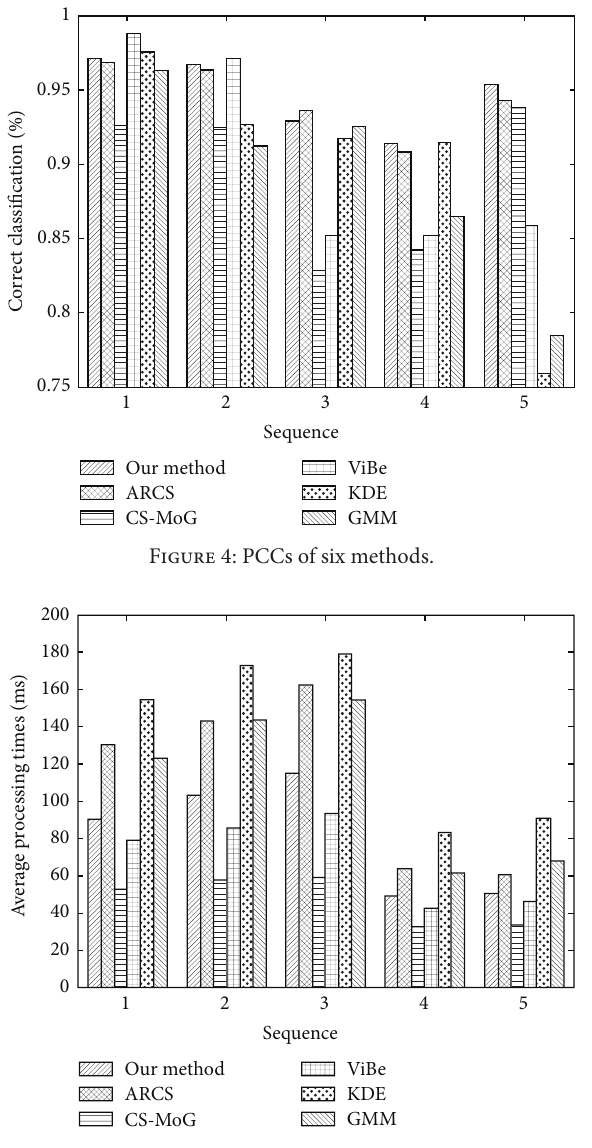
Figure 5: APTs of six